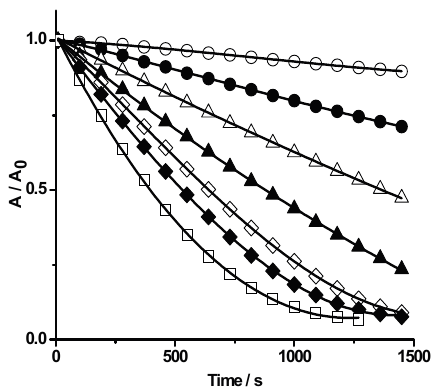
Figure 5. Influence of pH on the PGR (20 µM) bleaching mediated by HONO (40 µM). The time course of the reaction was followed by UV-visible spectroscopy ( λ = 465 nm) at different pH: 1.7 ( □ ), 2.0 (  ), 2.2 ( ◊ ), 2.4 ( ▲ ), 2.7 ( Δ ), 3.0 ( ● ), and 3.4 ( ○ ).